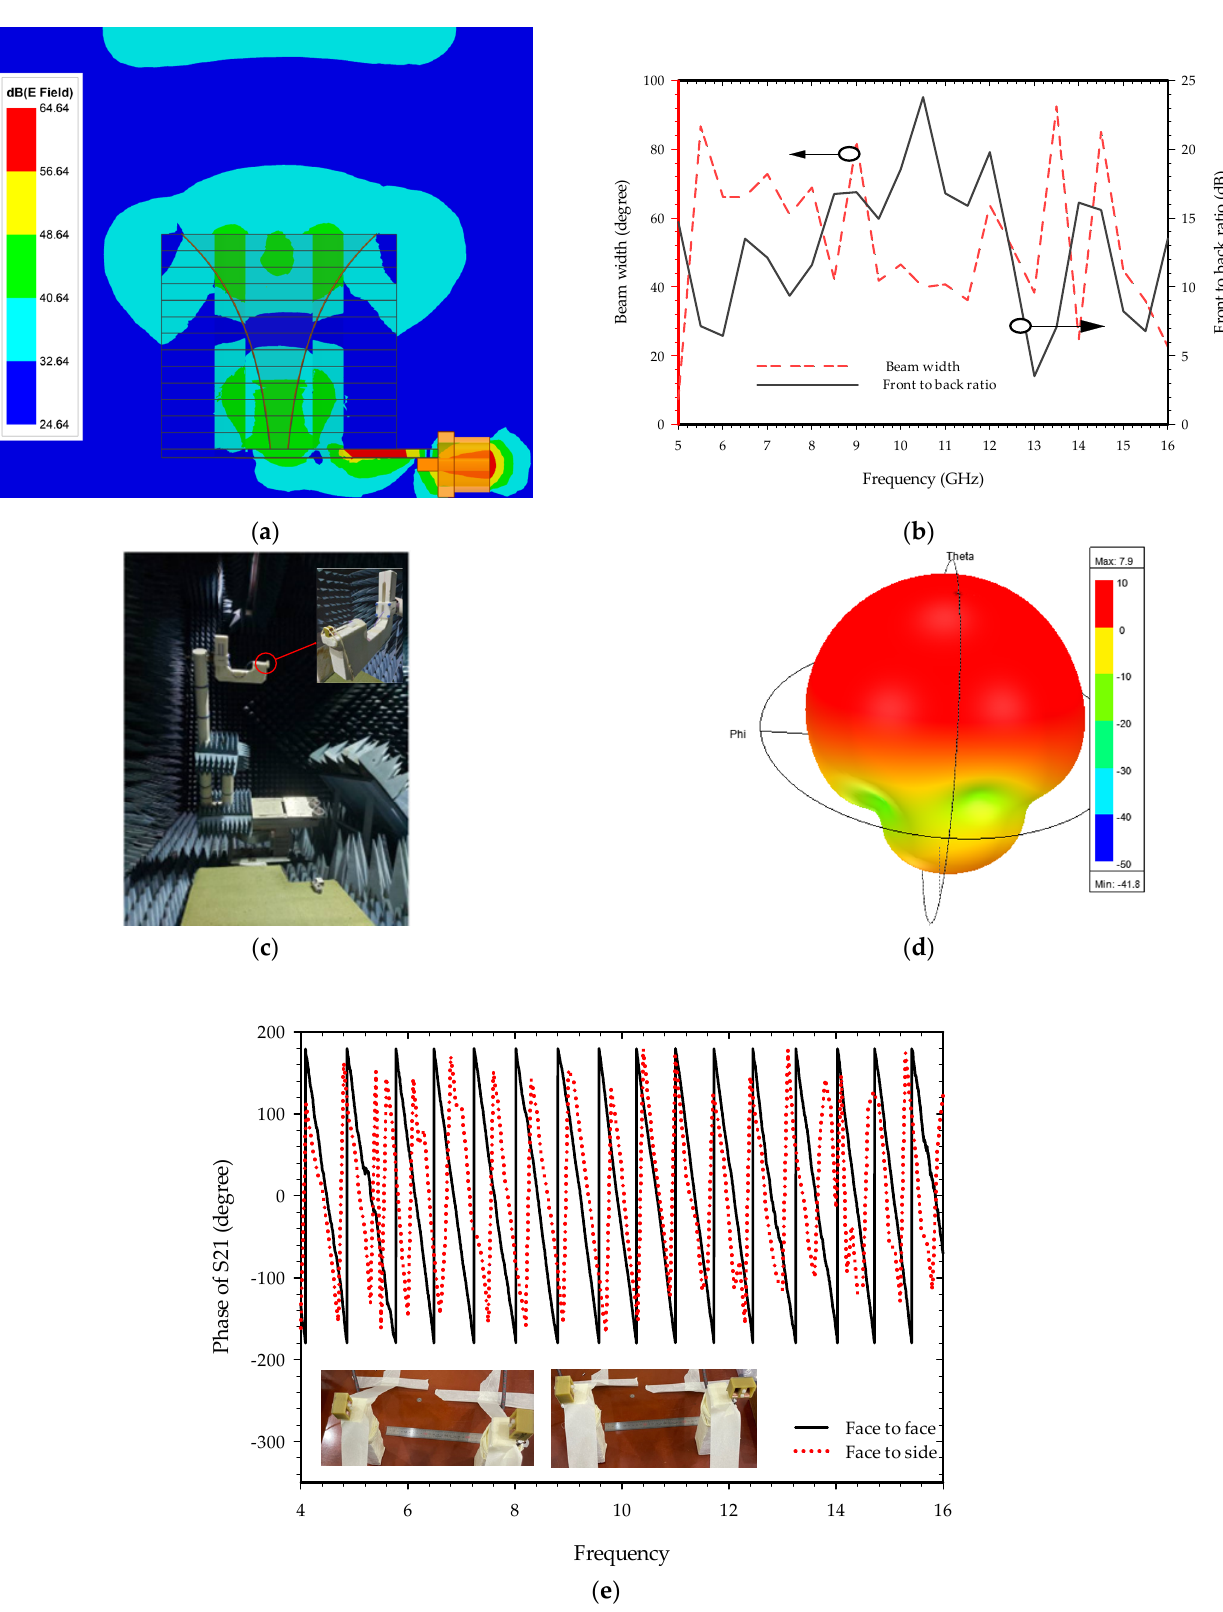
Figure 5. Far-field radiation beam components: ( a ) Electric field distribution plot at 6.8 GHz; ( b ) Front-to-back ratio and beam width; ( c ) Anechoic chamber measurement setup; ( d ) 3D radiation plot at 6.8 GHz; ( e ) Measured phase response of S21.